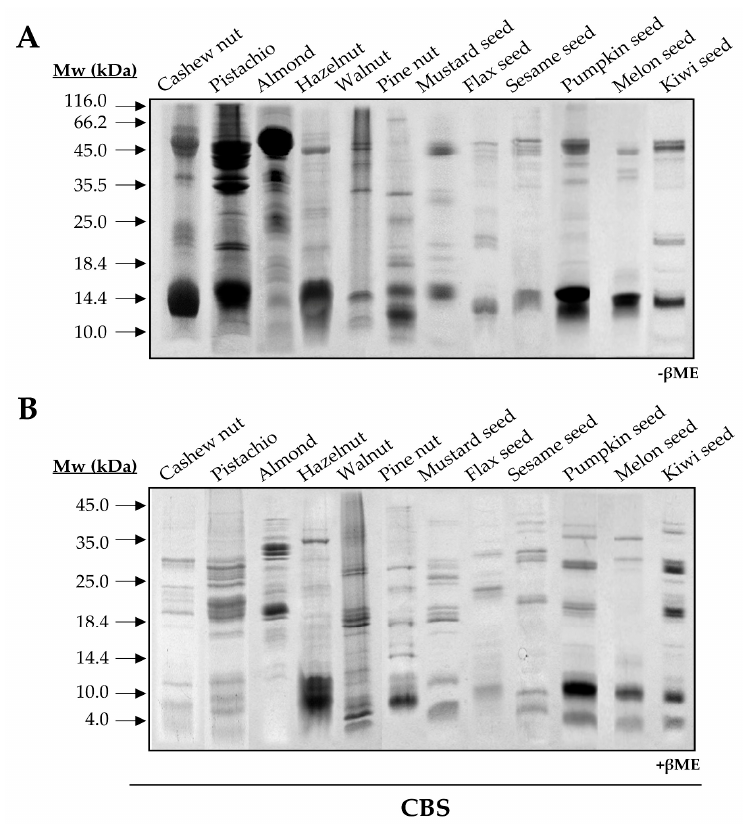
Figure A1. SDS-PAGE profiles of total protein extracts from plant-derived sources. Electrophoresis were conducted under non-reducing ( − β ME) ( A ) and reducing (+ β ME) ( B ) conditions, last one by treating samples with reducing agent β ME for 10 min at 90 °C.